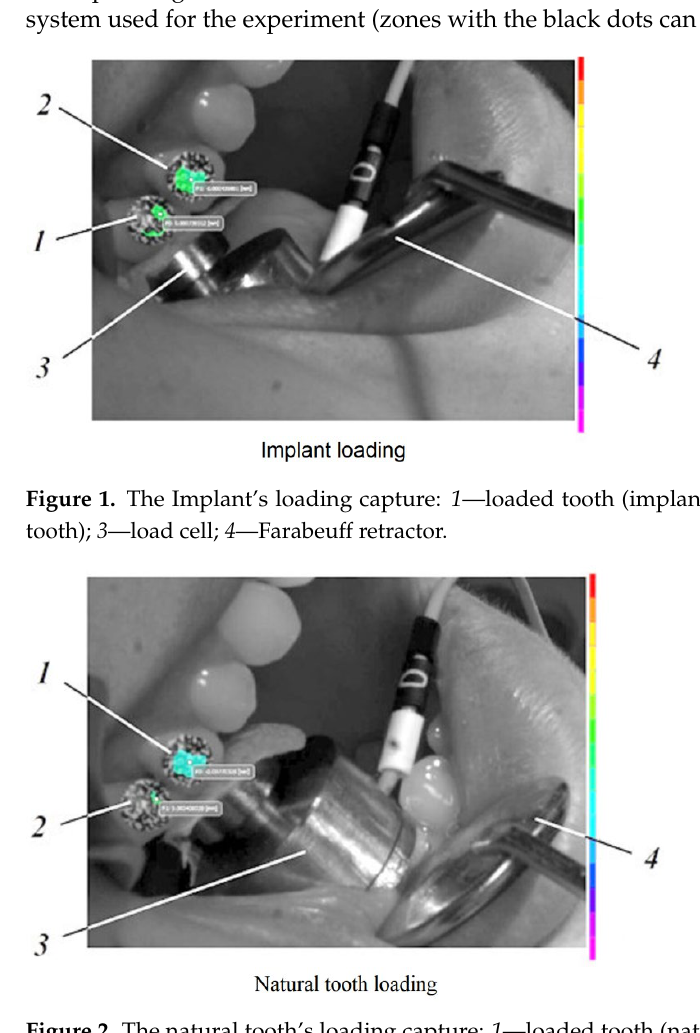
Figure 2. The natural tooth’s loading capture: 1 —loaded tooth (natural tooth); 2 —unloaded tooth (implant); 3 —load cell; 4 —Farabeuff retractor.